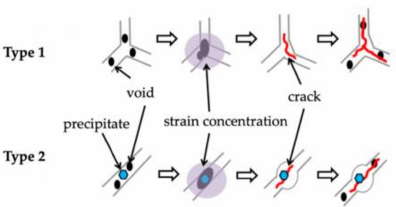
Figure 6. Schematic diagram of the ductility dip cracking